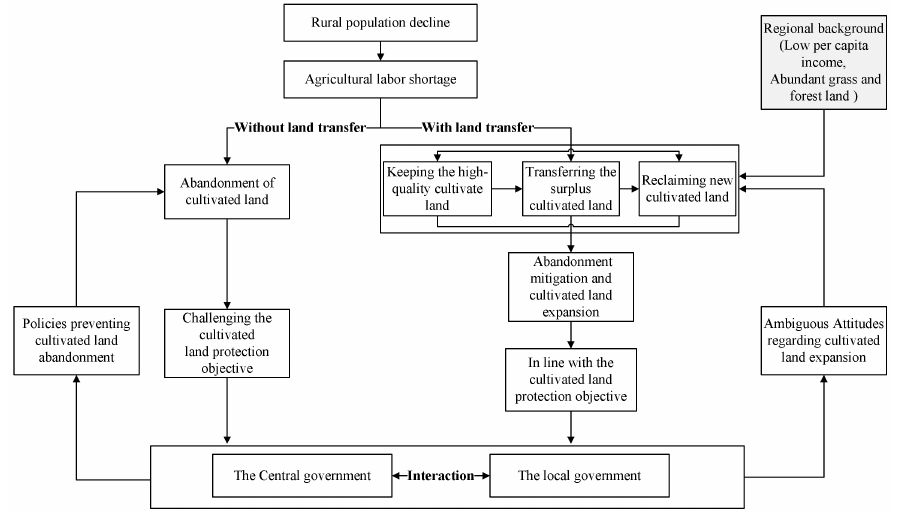
Figure 6. Two situations of cultivated land change without and with land